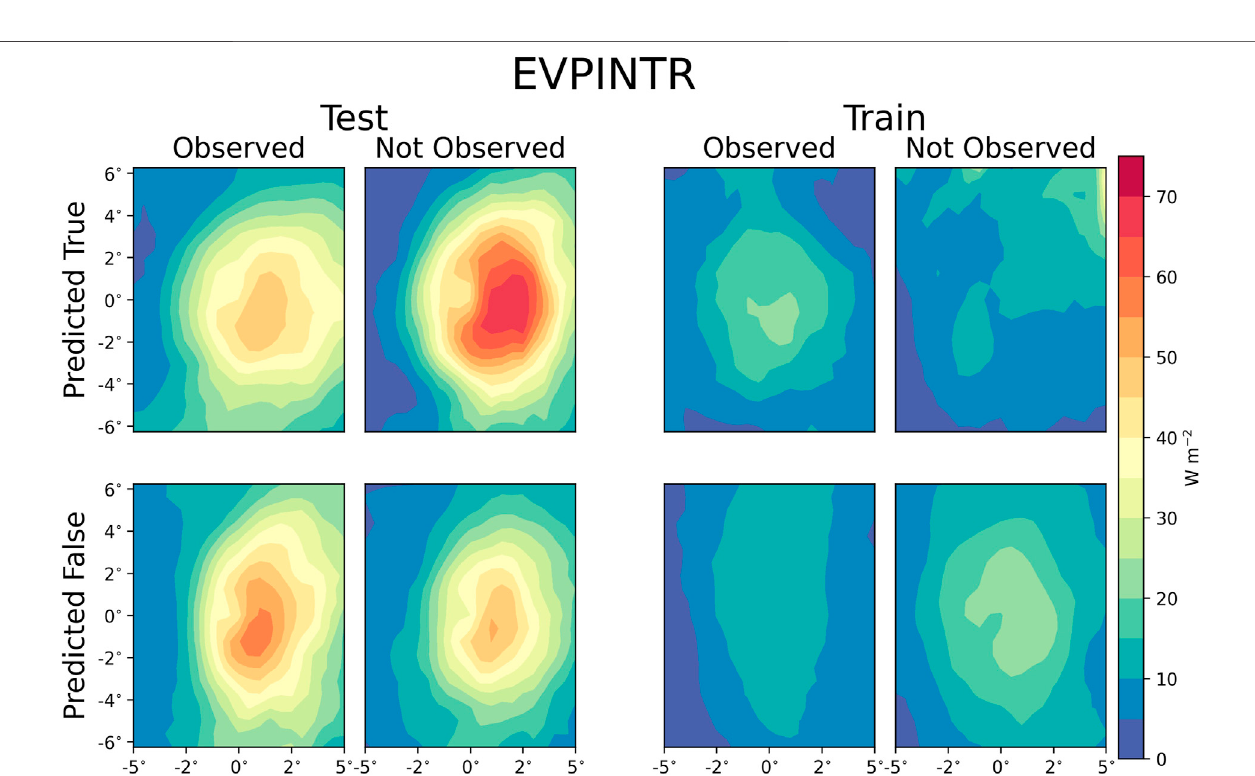
FIGURE 4 | Composite mean of the energy loss fl ux by interception (EVPINTR).